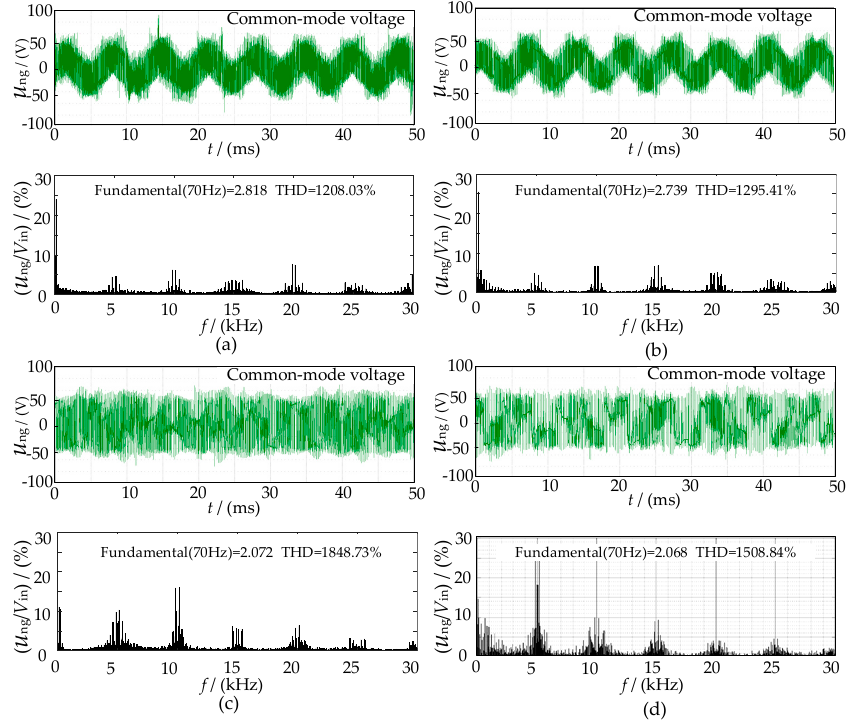
Figure 19. Experimental waveforms and FFT of CMV at m = 0.7 ( a ) method 1; ( b ) method 2; ( c ) method 3; ( d ) method 5.